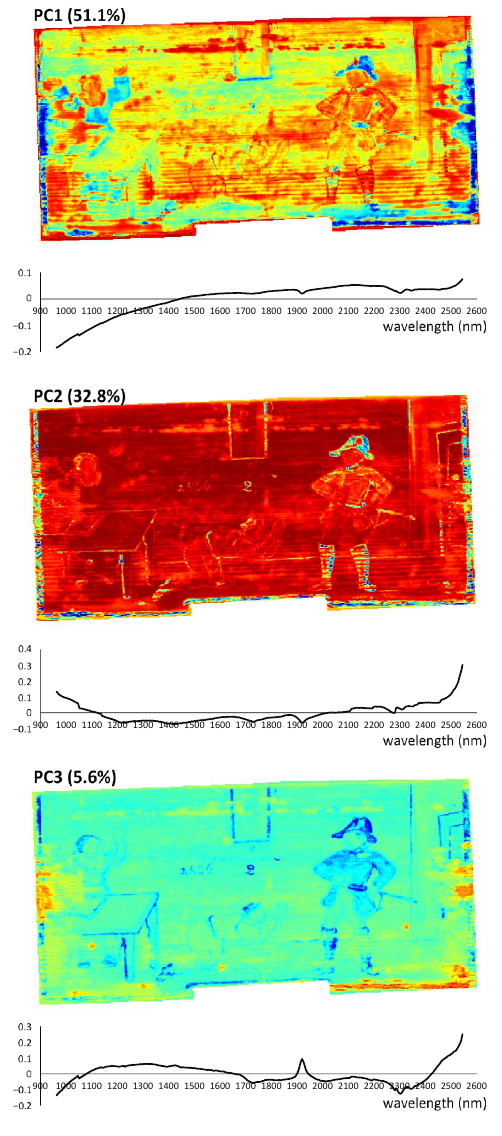
Figure 4. Results of PCA for images taken in the SWIR spectral range. Note: The percentages in parentheses explain the variances of all the individual principal components.